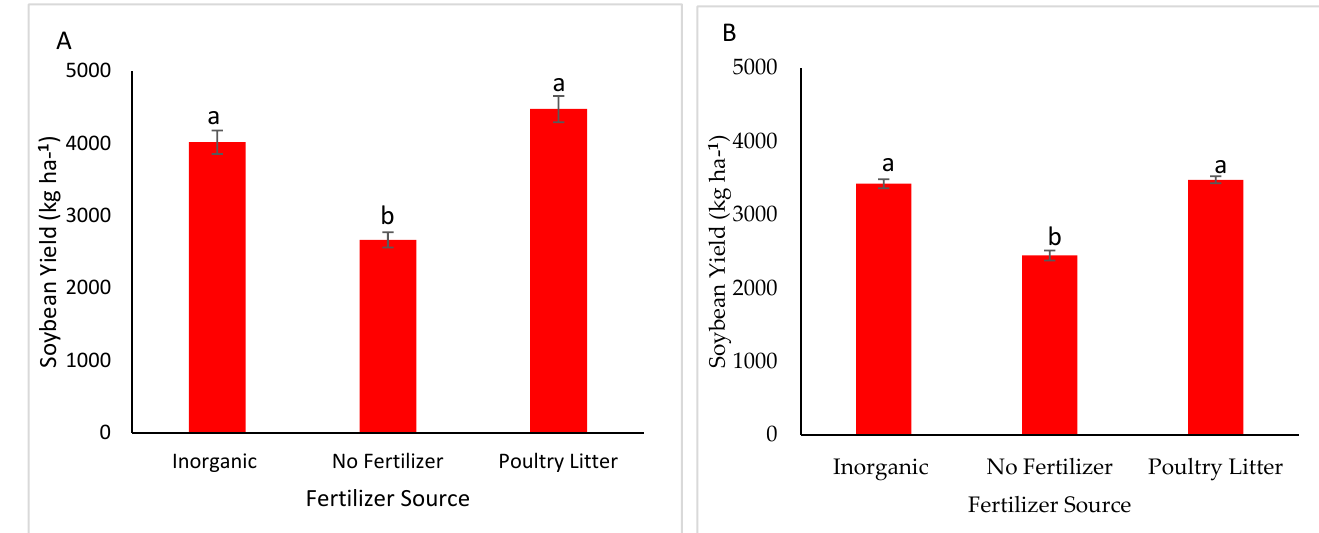
Figure 2. Fertilizer source effect on soybean yield ( A ) early planting date and ( B ) late planting date. The soybean yield is the average of two years (2019 and 2020). In 2018, heavy rainfall greatly reduced the soybean yield and thus these data were not included. Different letters indicate significant differences at p ≤ 0.05.